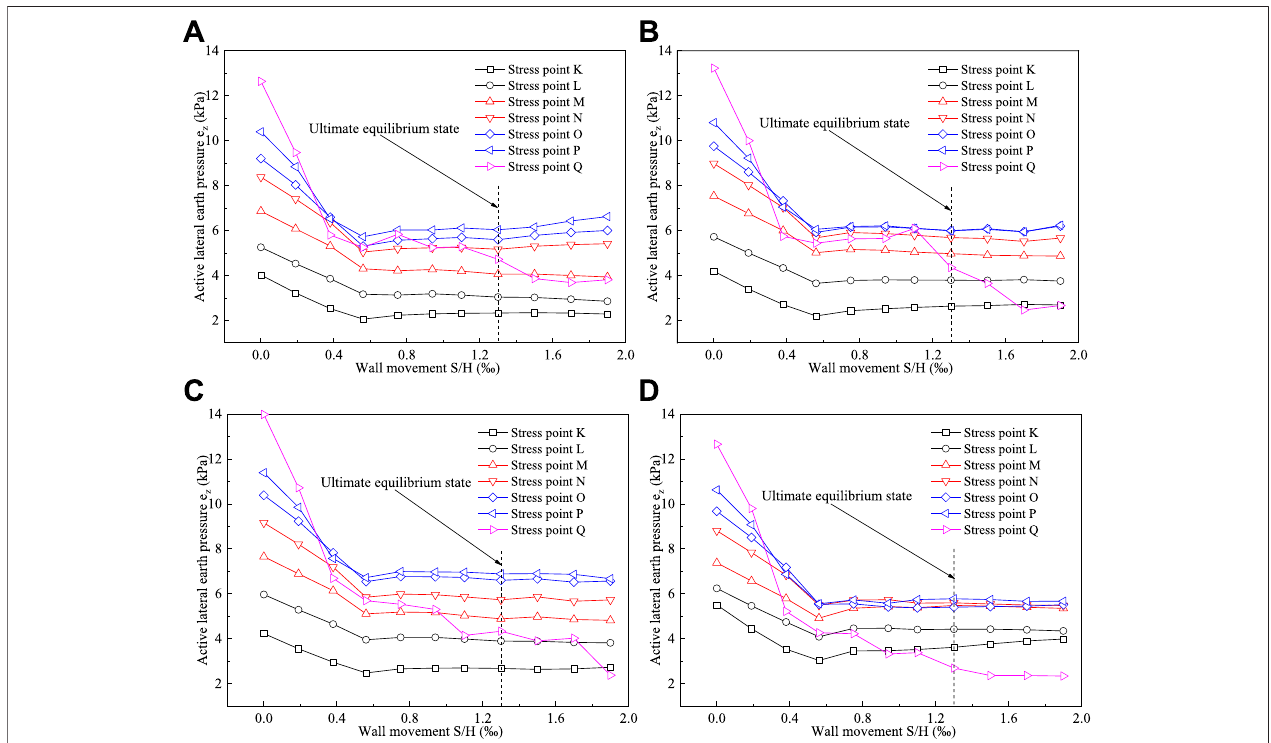
FIGURE 14| Active LateralEarth Pressure Finite Element Modeling with Retaining Wall Displacementin T Displacement Mode. (A) β =40 ° . (B) β = 50 ° . (C) β = 60 ° . (D) β = 70 ° .